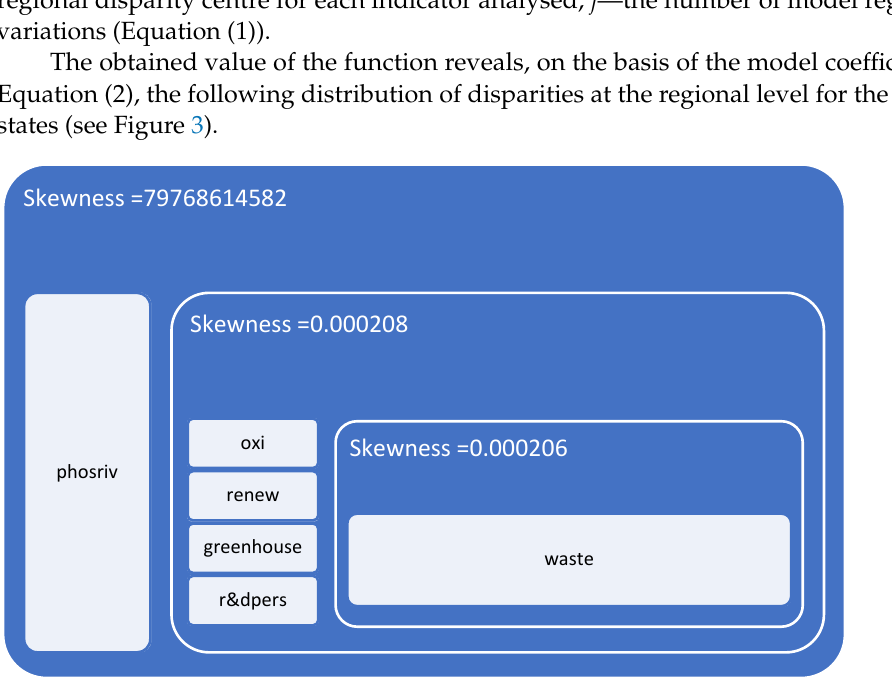
Figure 3. Green economy disparities in the EU. From the application of the model, a cohesion of waste management policies (“ waste ”) results as a fundamental element in the construction of the European green econ- omy in relation to allocated R&D expenditure. Secondly, significant cohesion was deter- ergy dimension—renewable component (“ renew ”) and the size of the population involved